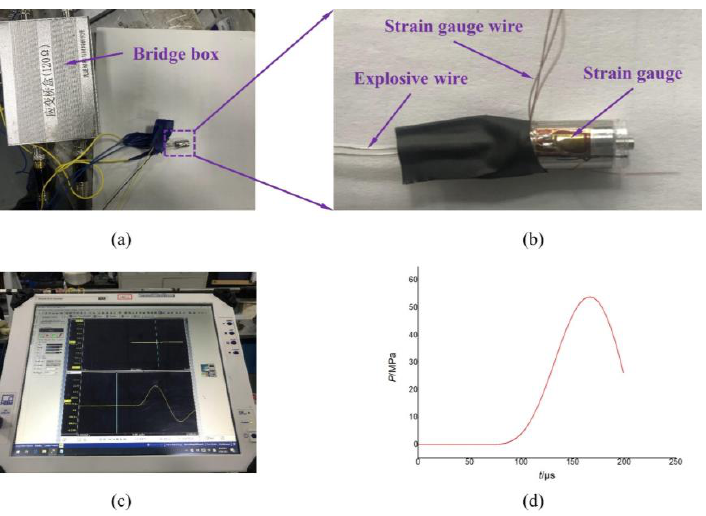
Figure 3. ( a ) strain gauge, ( b ) bridge box, ( c ) HBM GEN3i, ( d ) experimental p – t curve of propellant gas.